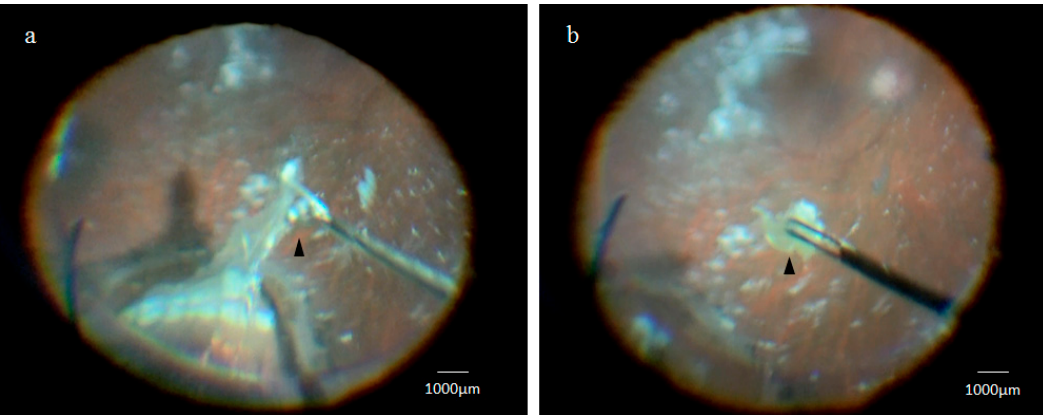
Figure 1. Intraoperative collection of the retinal lattice degeneration specimen. The retinal lattice degeneration specimen (black arrowhead) was held with vitreous forceps ( a ) and incised at the periphery of the lesion (black arrowhead) to selectively collect a specimen containing the lesion ( b ). This sections were then prepared by slicing the specimen parallel to the retinal surface for hematoxylin staining, and whole mounts were prepared for glial fibrillary acidic protein (GFAP), retinal pigment epithelium-specific protein 65 kDa (RPE65), pan-cytokeratin (pan-CK), and cytokeratin (CK)18